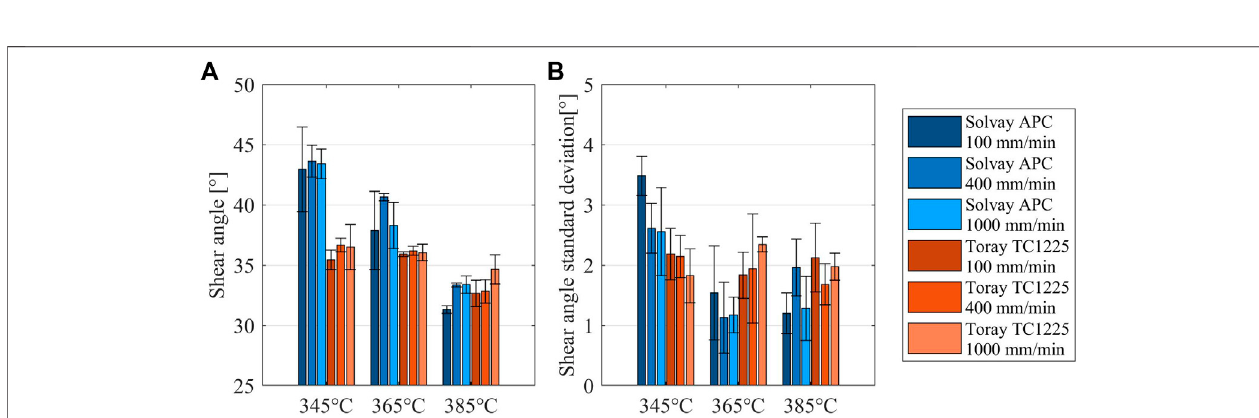
FIGURE8| FinaldeformationinthecentralareaIforallconditionstested. (A) Meanshearangle. (B) Standarddeviationoftheshearangledistribution,asameasure for homogeneity.